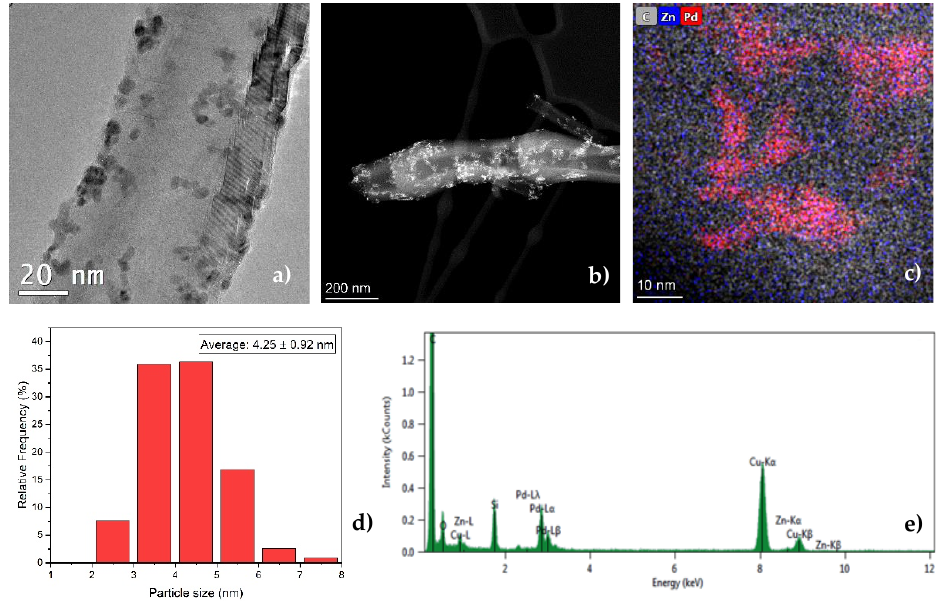
Figure 6. ( a ) TEM, ( b ) HAADF-STEM, ( c – e ) XEDS mapping and spectrum of a representative area, and ( d ) particle size distribution of 1%Pd 8 Zn 2 /HHT.